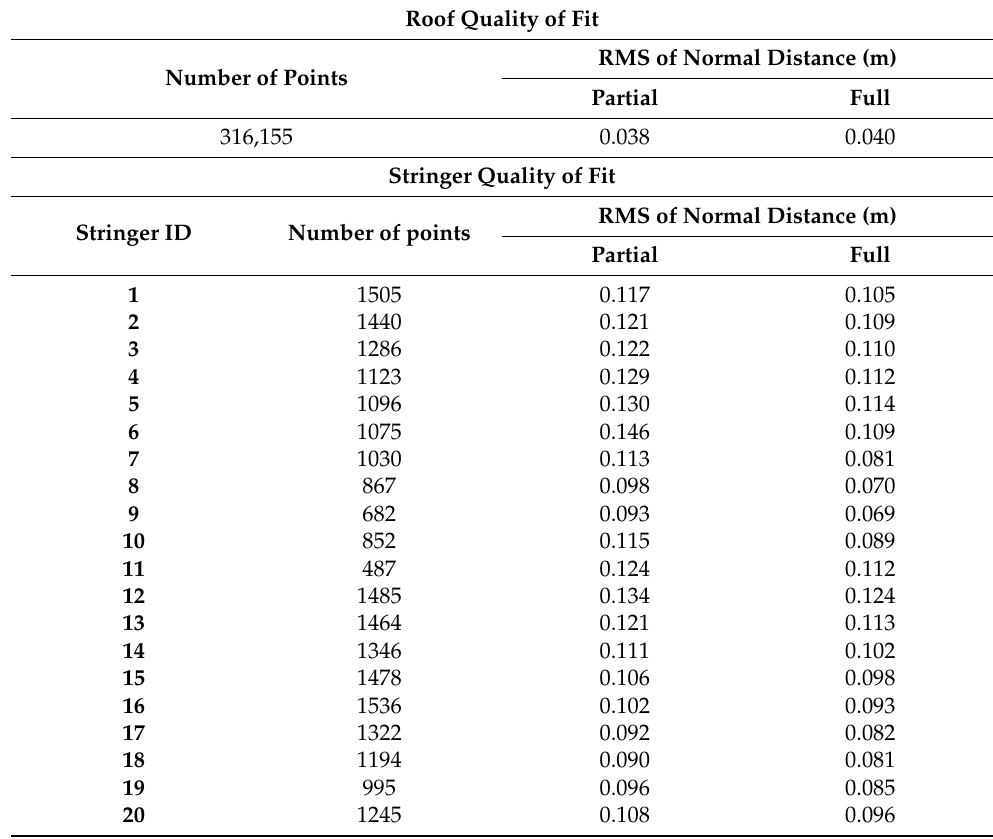
Table 4. RMS of the fitting error for the registration primitives ( roof and stringers ) in the Lebanon dataset following the partial/full fine